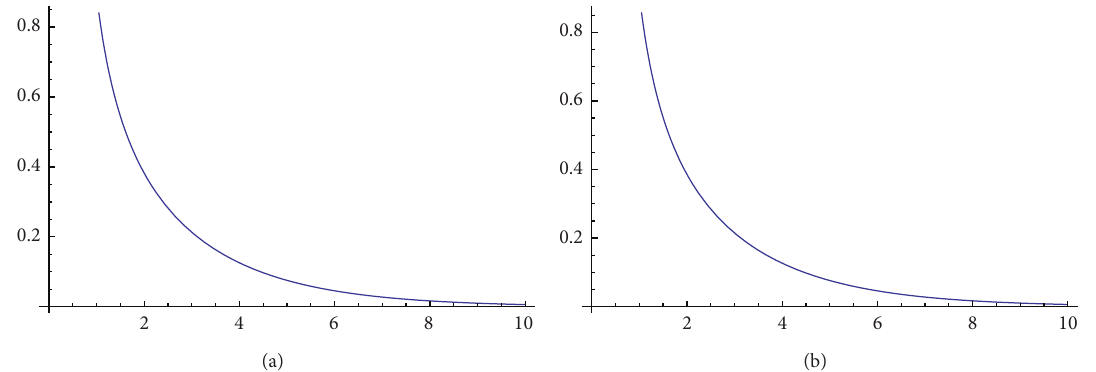
Figure 2: Two-dimensional graph of the solution (21) corresponding to the values 𝛼 = 0.05 , 𝛼 = 0.85 , respectively, when 𝑘 = 1 , 𝑝 = 2 , 𝑎 1 = 1 , = 2 , 𝛽 = 3 , 𝑡 = 1 , and 0 < 𝑥 < 10 𝑏 0